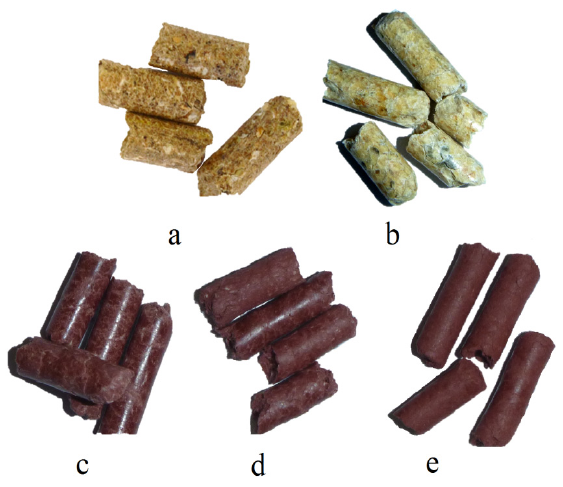
Figure 1. Examples of pellets: ( a ) From shredded furniture boards only; ( b ) From spruce wood only; ( c ) 5% Fe 2 O 3 content; ( d ) 10% Fe 2 O 3 content; and ( e ) 15% Fe 2 O 3 content.